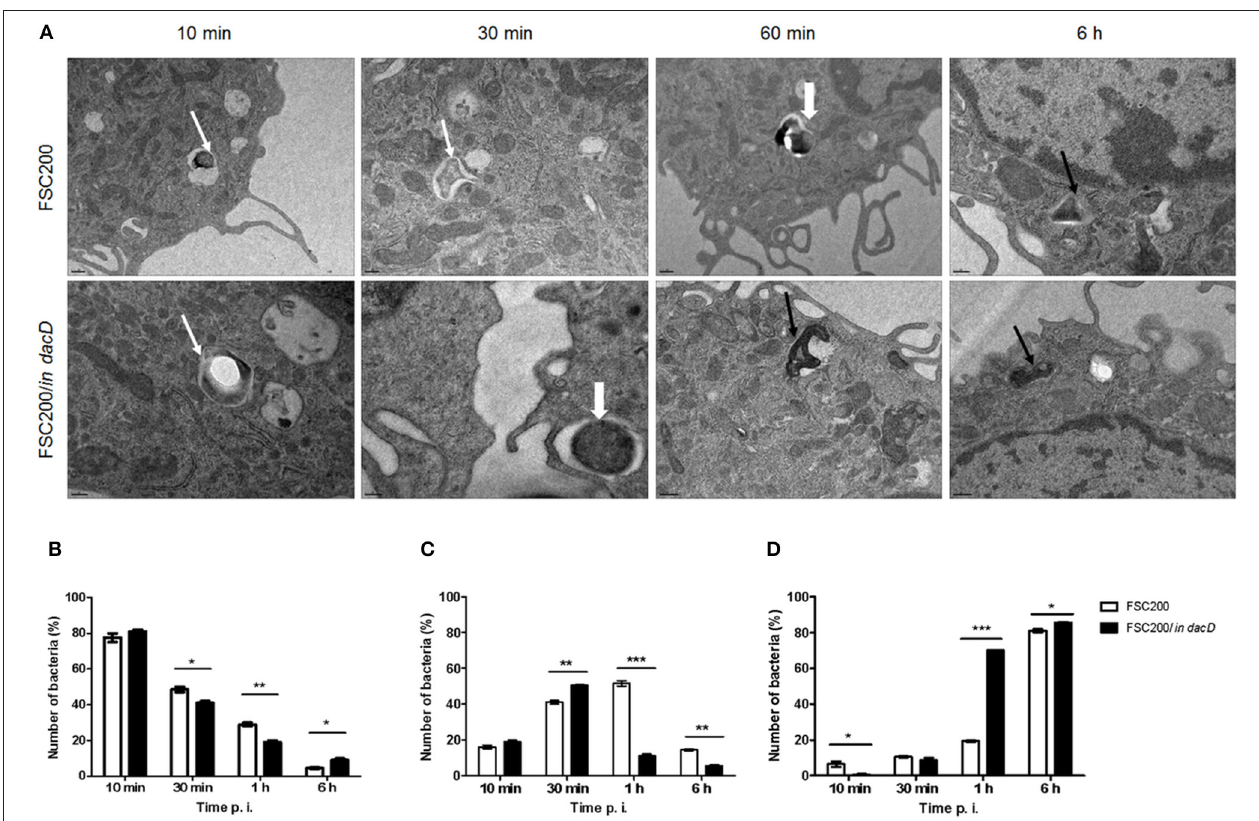
FIGURE 2 | Intracellular fate of FSC200/ in dacD . (A) Representative transmission electron microscopy images of BMMs infected with wild-type and FSC200/ in dacD mutant strains at indicated time intervals after infection. Thin white arrows show intact phagosome, thick white arrows show damaged phagosomal membrane, while thin black arrows show bacteria free in the cytosol. (B–D) Quantification of bacteria inside intact phagosomes (B) , phagosomes with damaged membrane (C), and bacteria free in cytosol (D) . * P < 0.05, ** P < 0.01, *** P <